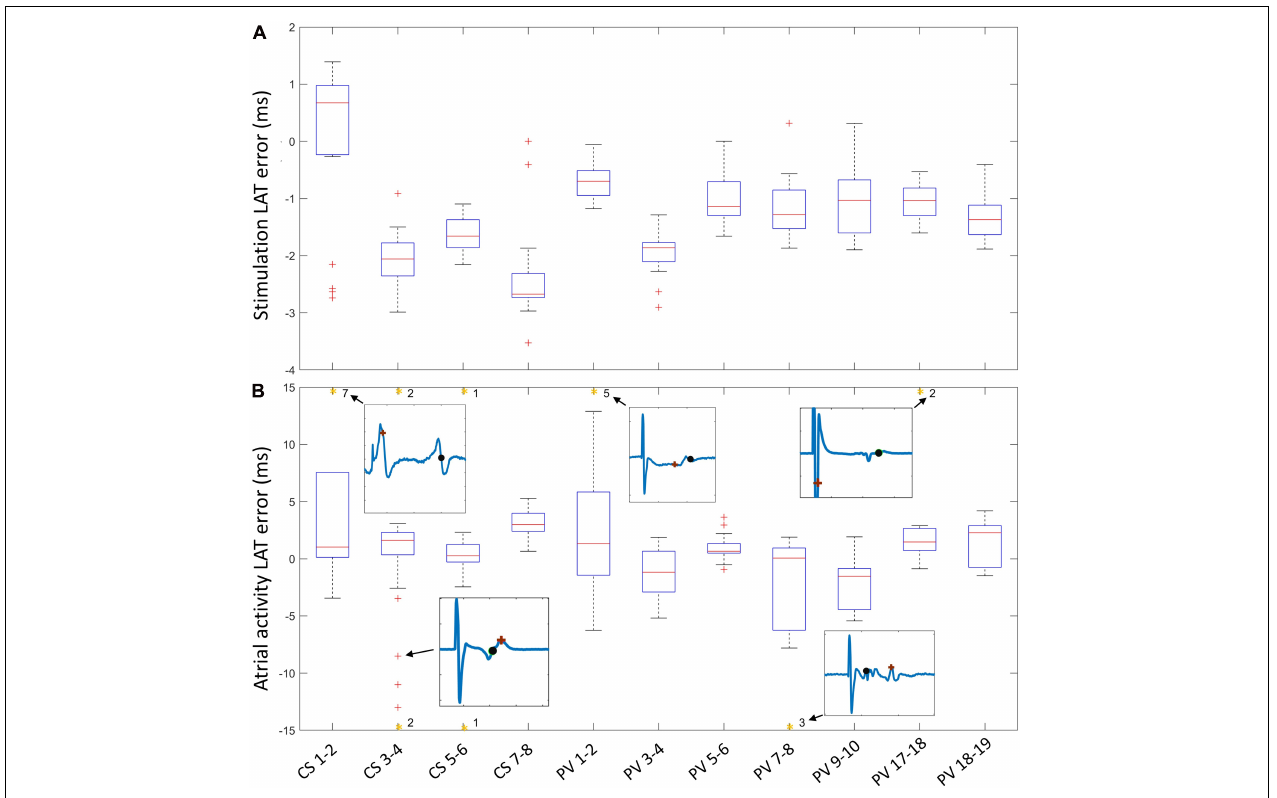
FIGURE 7 | LAT error of stimulation signal (A) and atrial activity (B) calculated by subtraction of pipeline LAT from expert annotation. The number of outliers beyond the y -axis limit (orange asterisk) is shown, along with an exemplary signal showing the differences between the expert annotation (black) and the pipeline annotation